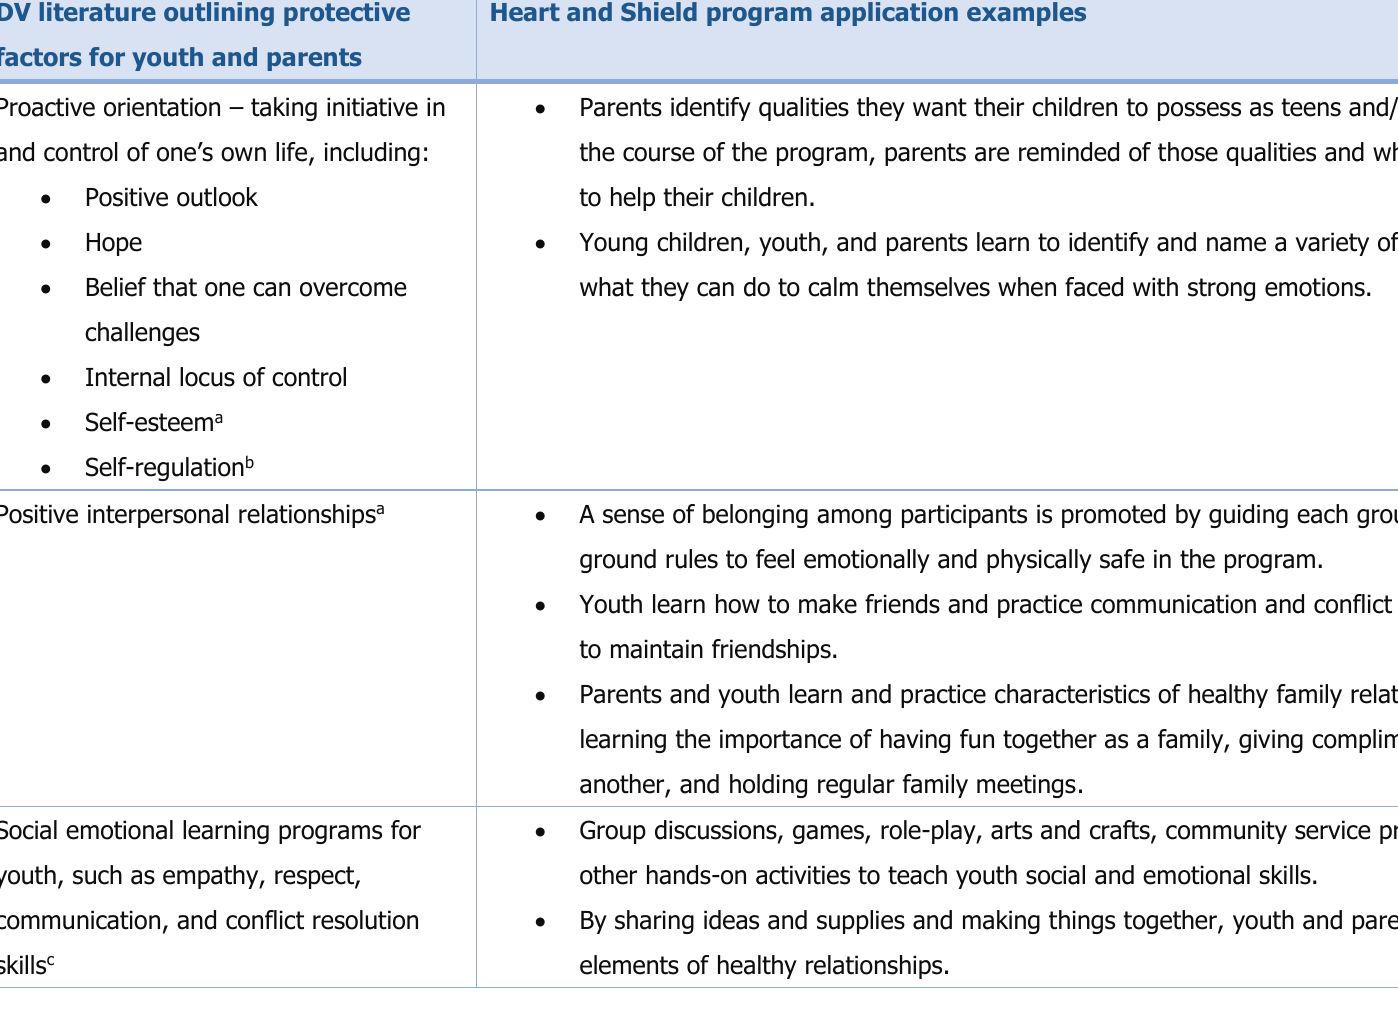
Table 2. Heart and Shield Protective Factors Research Applications DV literature outlining